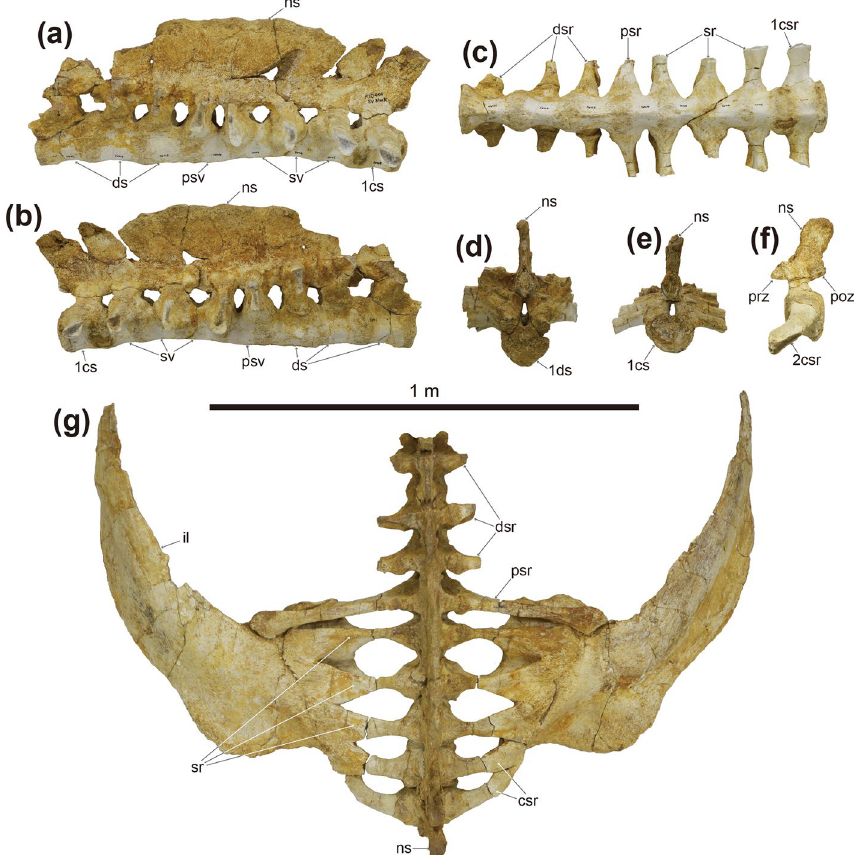
Figure 6. Photographs of the synsacrum ( a – f ), and ilia ( g ) of Tarchia tumanovae sp. nov. (MPC-D 100/1353). Synsacrum in ( a ) left lateral, ( b ) right lateral, ( c ) ventral, ( d ) anterior, and ( e ) posterior views. ( f ) Second caudosacral vertebra in left lateral view. ( g ) Synsacrum with the fused ilia in dorsal view. cs caudosacral vertebra, csr caudosacral rib, ds dorsosacral vertebra, dsr dorsosacral rib, il ilium, ns neural spine, psr parasacral rib, psv parasacral vertebra, sr sacral rib, sv sacral